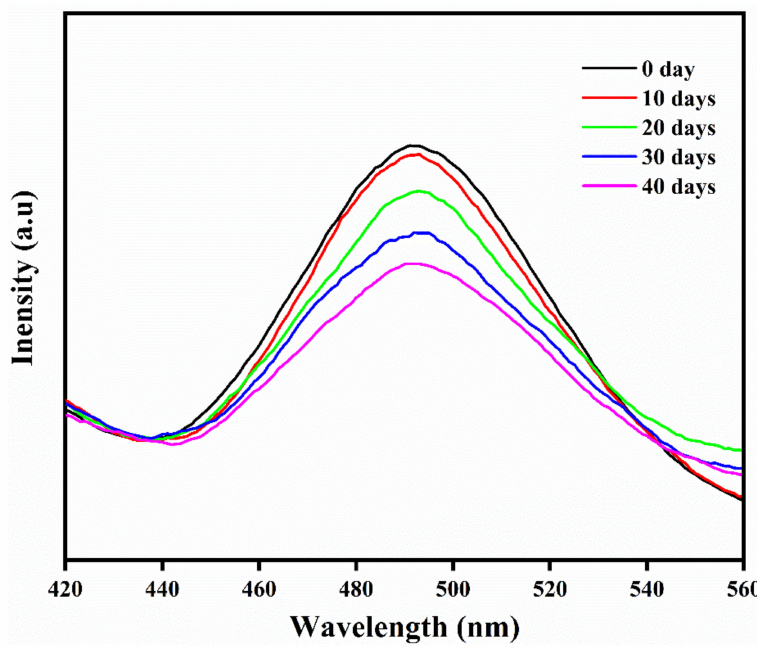
Figure 9. Phosphorescence decay for HDPE/3AG 1 composites every 10